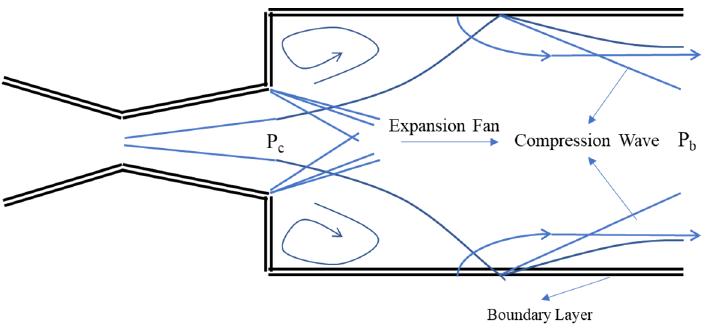
Figure 1. Sudden expansion flow field. Reprinted with permission from ref. [2]. Copyright 2021 Springer.